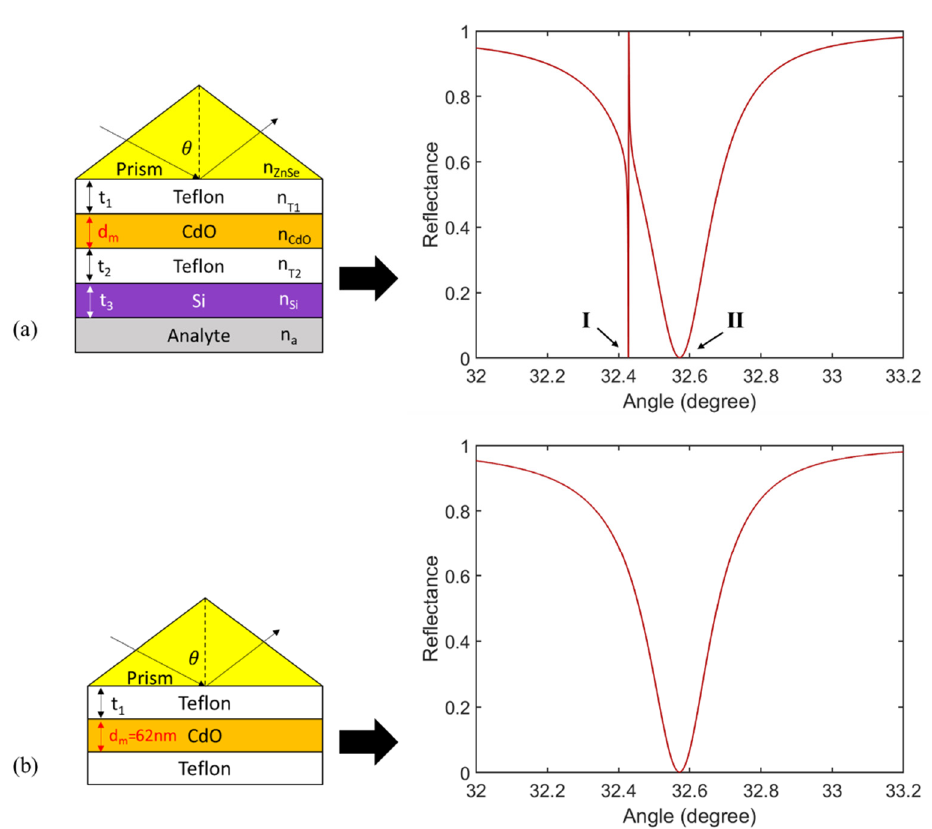
Figure 6. Schematic diagram and the corresponding reflection spectra of ( a ) the proposed 6 ‐ layer Fano resonance structure at λ =1.89 μ m and ( b ) the 4 ‐ layer LRSPR structure for comparison.